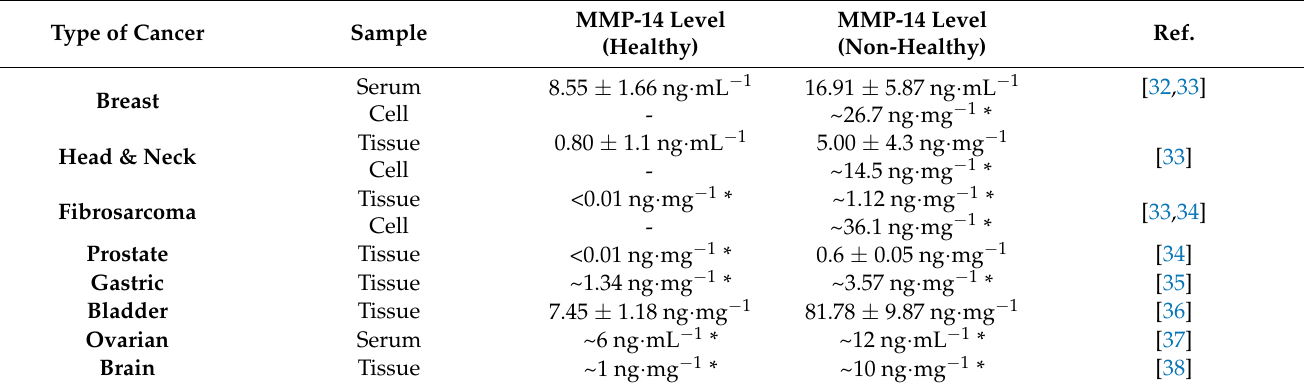
Table 1. Abnormal expression of MMP-14 for different types of cancer and body